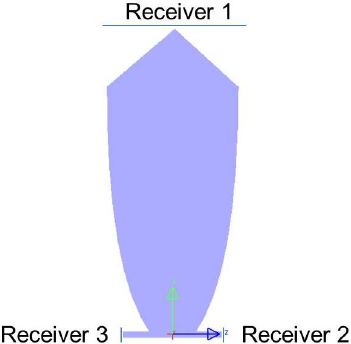
Figure 5. The simulation structure for optical efficiency analysis.